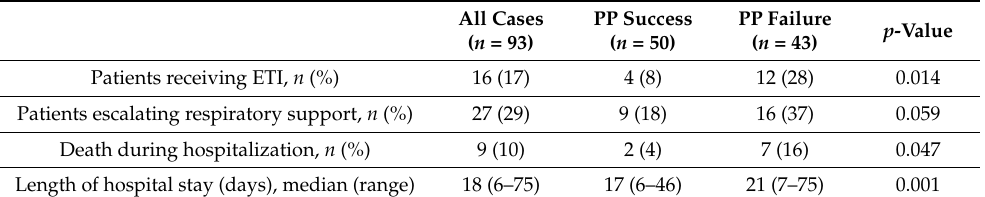
Table 2. Patients’ outcomes following RICU admission. (ETI= Endotracheal Intubation; PP = Prone Positioning). p -values refer to differences between Prone Positioning (PP) success and PP failure groups.